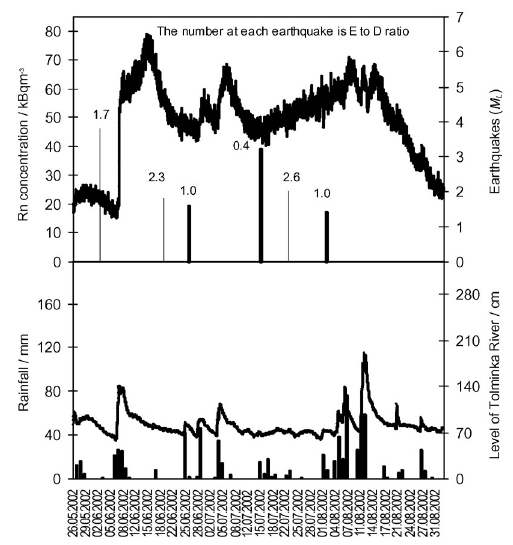
Fig. 5. Rn concentration (kBqm –3 ), earthquakes ( M L ), rainfall (mm) and the level of the Tolminka Riv- er (cm) in the thermal spring at Zatolmin between Au- gust and October